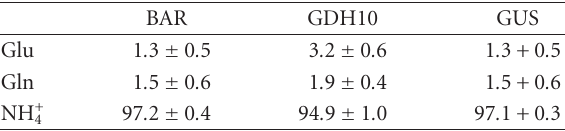
Table 2. Labeling of the glutamate pool via absorption of 13 NH + 4 in intact roots of transgenic plants treated with 1 mM MSX for 2 hours before feeding. Tracer exposure was for 15 minutes. In- corporation is expressed as a percentage of the label input plus or minus the range detected among 3 individual plant replicates and three measurement